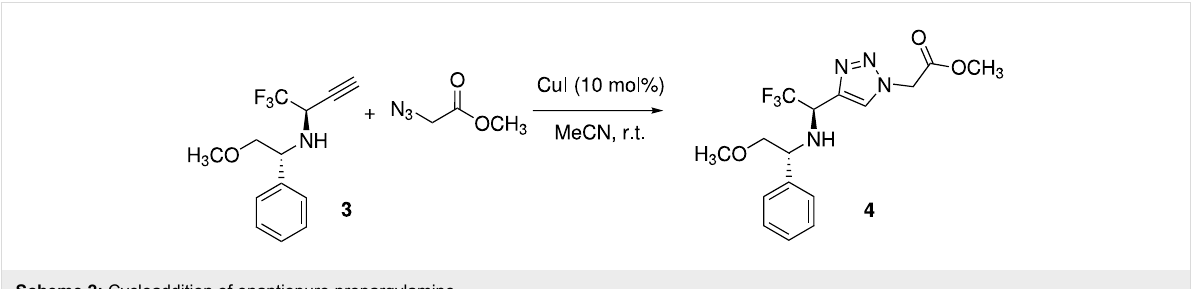
Scheme 2: Cycloaddition of enantiopure propargylamine.